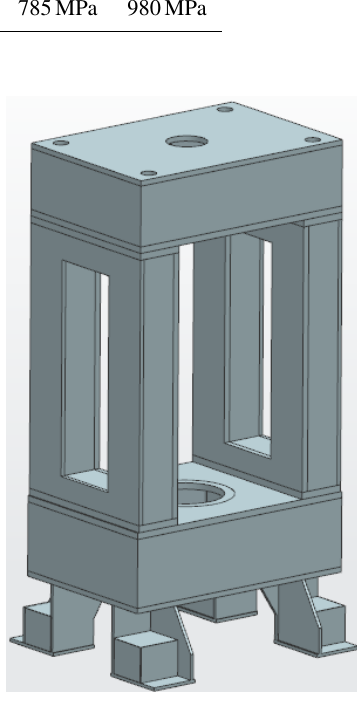
Figure 4. Simplified model of